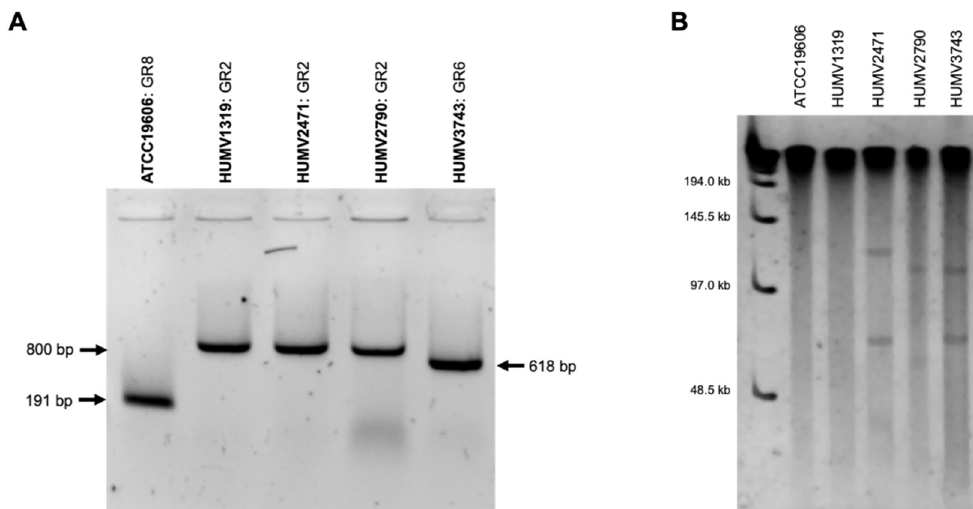
Figure 4. Molecular detection of plasmids in A. baumannii . ( A ) PCR-based replicon type (PBRT) and ( B ) PFGE gel for plasmids detection in A. baumannii strains. In ( B ), a molecular size ladder (Lambda ladder PFGE marker, NEB Biolabs) was used in first lane.